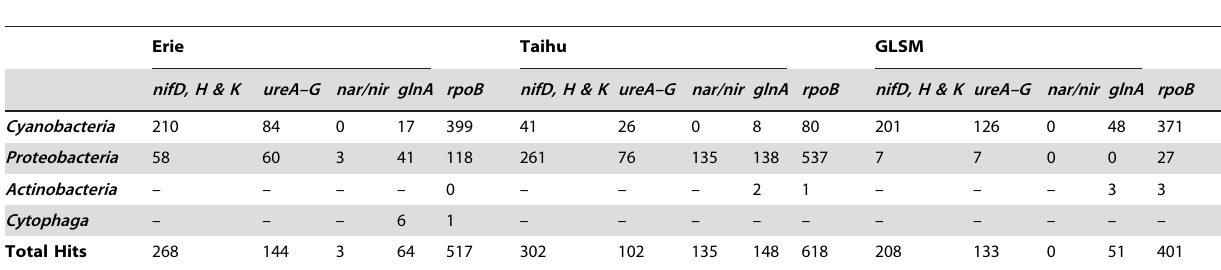
Table 3. The abundance of microbial nitrogen assimilation genes within